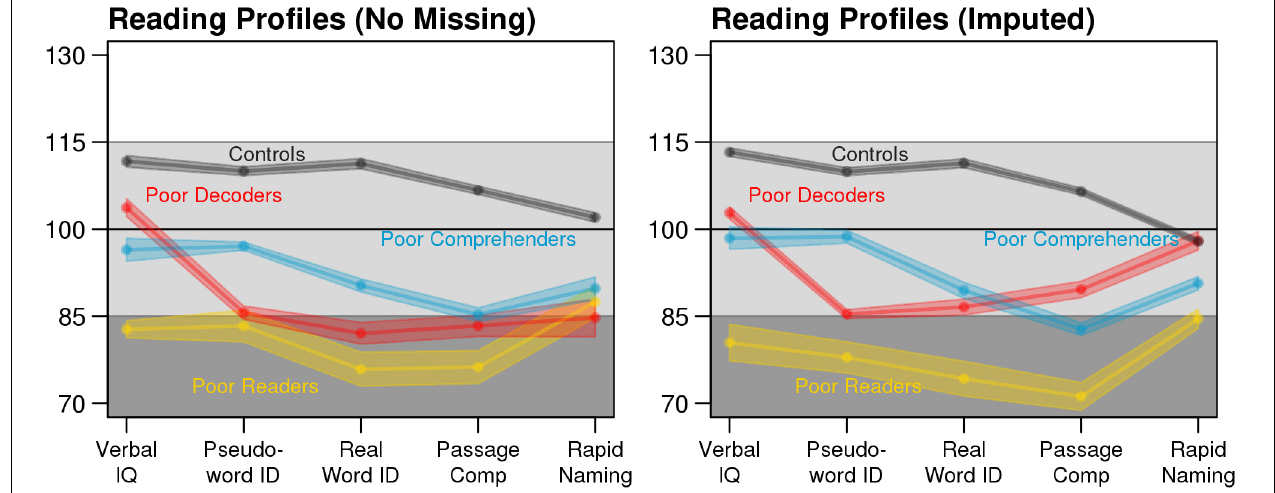
FIGURE 5 | The same reading profiles are observed in the training dataset ( N = 198) and MI test dataset ( N = 726; pooled estimates from the m = 10 missForest imputations). Shaded area depicts the SEM.